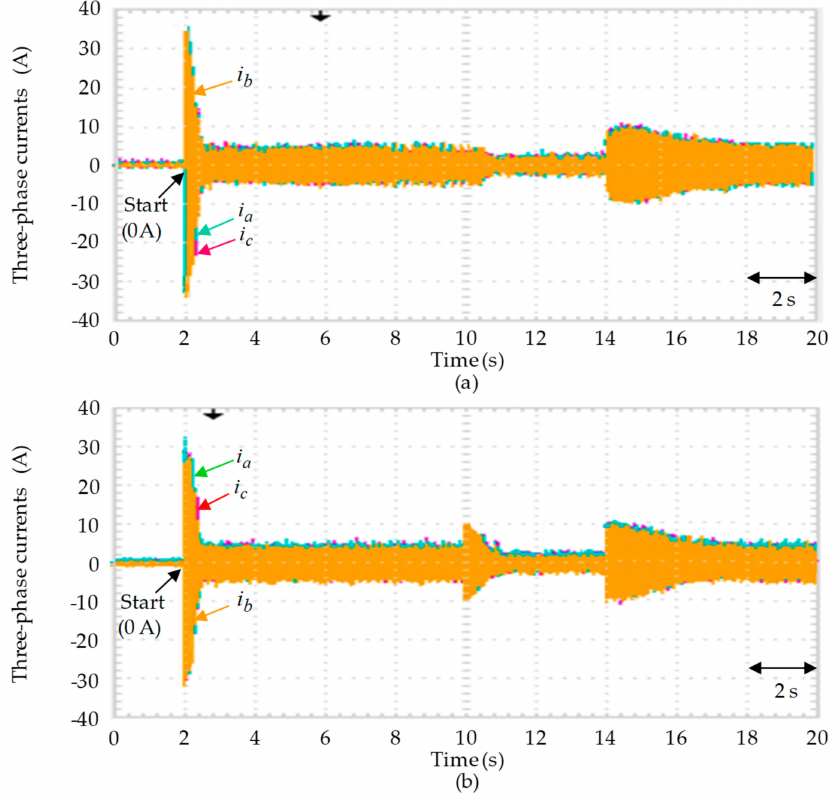
Figure 14. Responses of three-phase currents with adding load torque via experimental results of test JC by adopting the controllers: ( a ) TA; ( b )